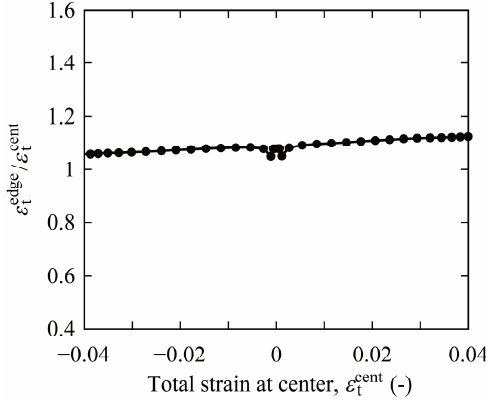
Figure A4. Strain concentration of a specimen with 5 mm thickness subjected to bending. The values of ε t edge and ε t cent represent the strains at the specimen edge and the specimen center, respectively, shown in Figure A1.